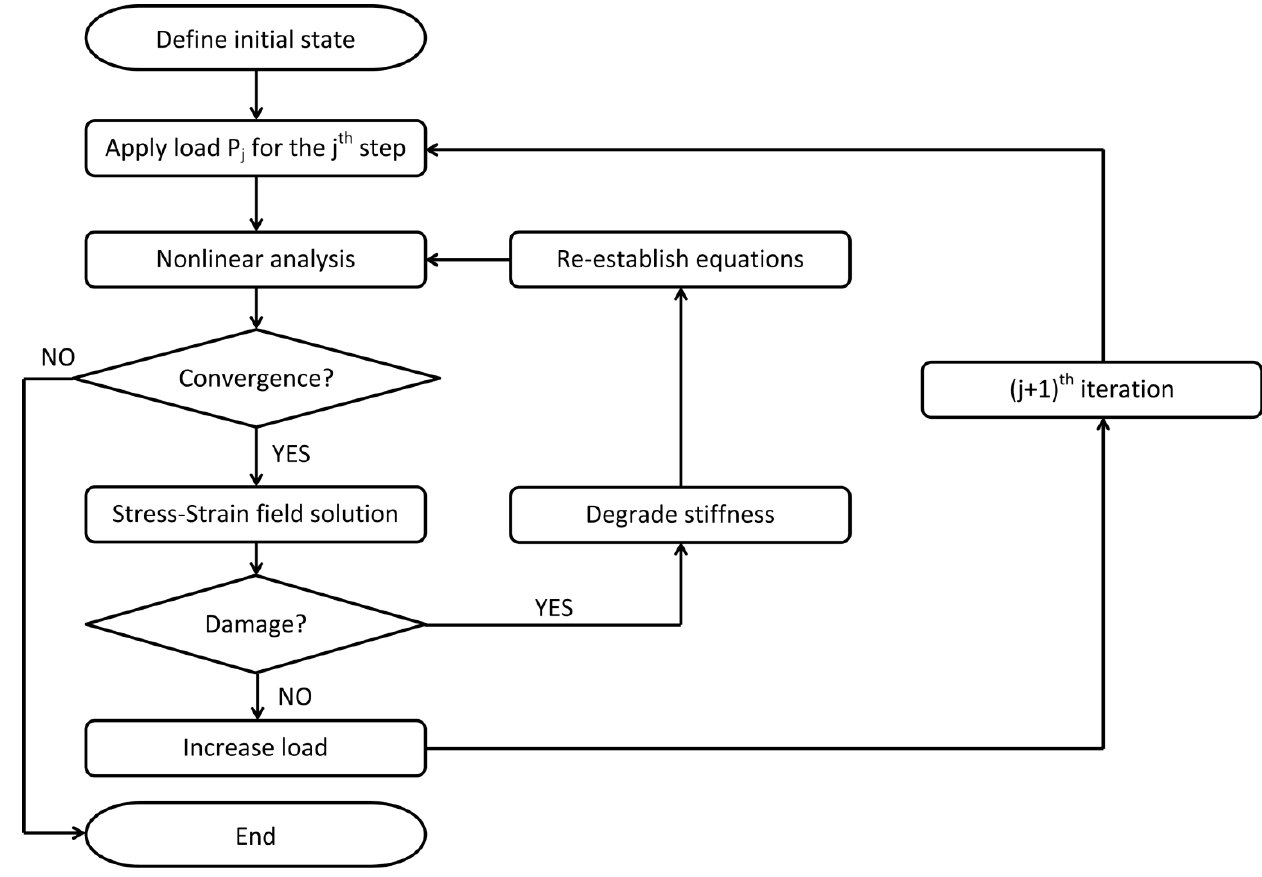
Figure 1. Main progressive damage analysis